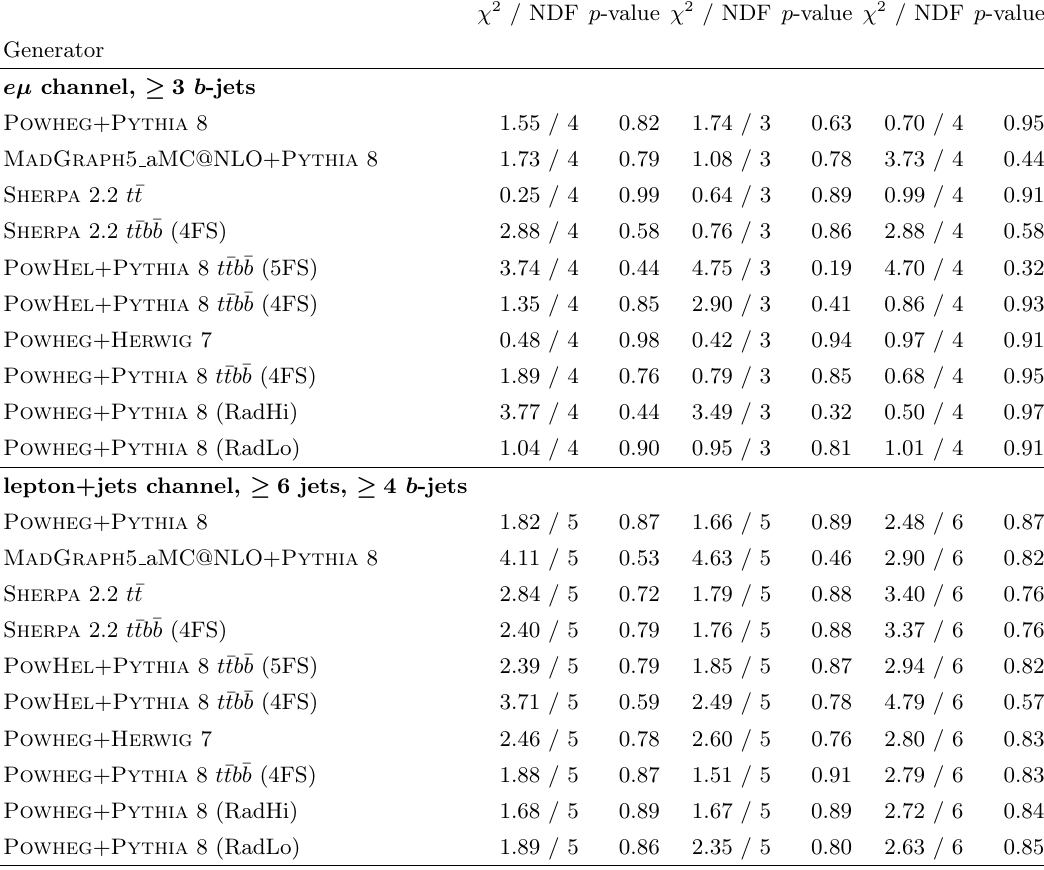
Table 10. Values of (cid:31) 2 per degree of freedom and p -values between the unfolded normalised cross- sections and the various predictions for the mass, p T and (cid:1) R of the leading two b -jets in the e(cid:22) and lepton + jets channels. The number of degrees of freedom is equal to the number of bins in the measured distribution minus